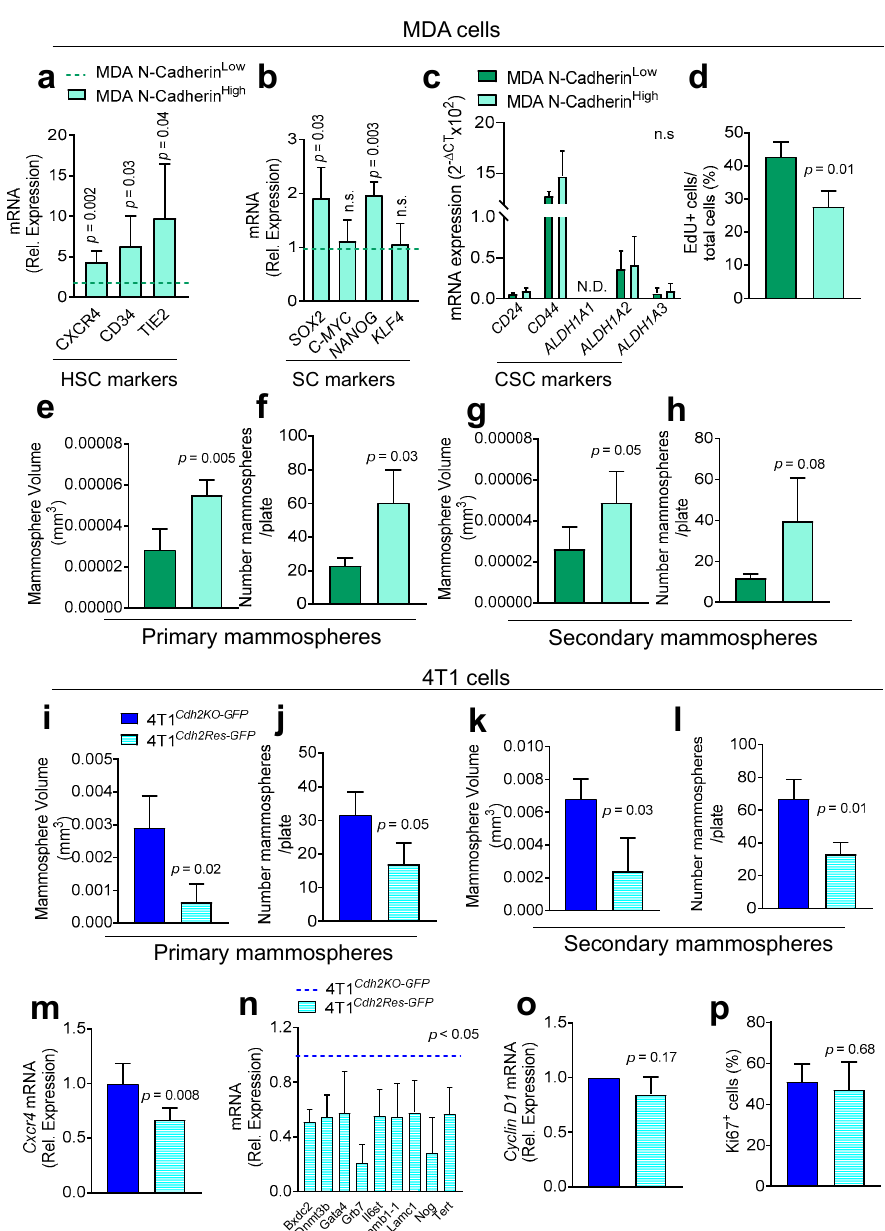
Figure 5. Effect of N-Cadherin expression on HSC mimicry and stemness of MDA and 4T1 BrCa cells. MDA cells were sorted into N-Cadherin High and N-Cadherin Low subpopulations by MACS. Real-time RT-PCR was used to assess the expression of the indicated ( a ) HSCs, ( b ) Stem Cell (SC) and ( c ) Cancer Stem Cell (CSC) markers. Human GAPDH was used to normalize gene expression. ( d ) 5-ethynyl-2 ′ -deoxyuridine (EdU) assay was used to assess cell proliferation. ( e ) Size and ( f ) number of primary mammospheres obtained from MACS-sorted N-Cadherin High and N-Cadherin Low MDA cells. ( g ) Size and ( h ) number of secondary mammospheres obtained after trypsinization and re-plating single cells harvested from the primary MDA mammospheres. ( i ) Size and ( j ) number of primary mammospheres obtained from 4T1 Cdh2-KO and 4T1 Cdh2-Res GFP cells. ( k ) Size and ( l )